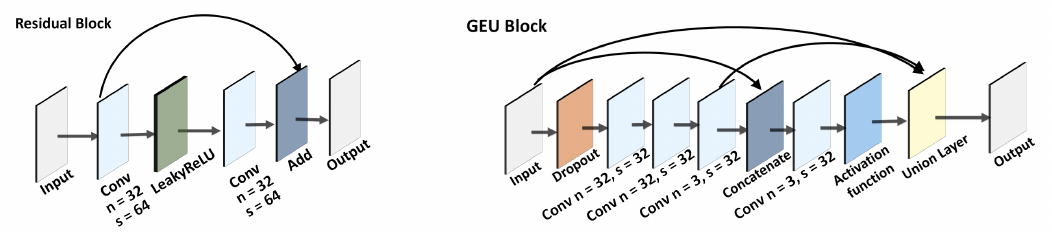
Figure 7. The Residual Block [25] and GEU block [38] visualization, where n denotes the number of filters and s is the features